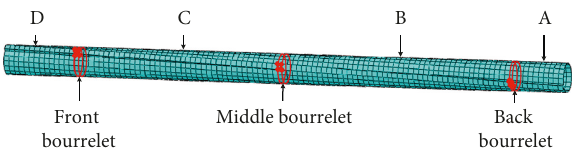
Middle bourreletFront bourrelet Figure 6: Structure of composite-material direction pipe. Figure 7: Finite element model of composite-material direction